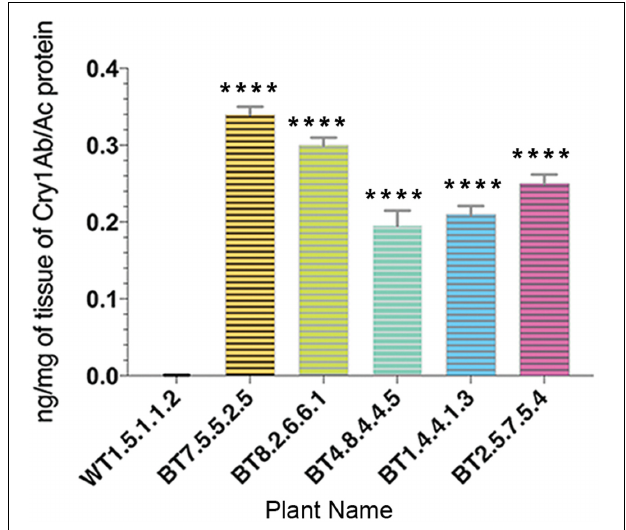
FIGURE 5 | Enzyme linked immunosorbent assay quantification showing variation in Cry1Ab/Ac protein expression in different transgenic plant lines. All data were expressed as the mean ± SE of 3 replicates. Significant difference ( ∗∗∗∗ P < 0.0001) in endotoxin expression in transgenics compared to non-transgenic (WT) in T 4